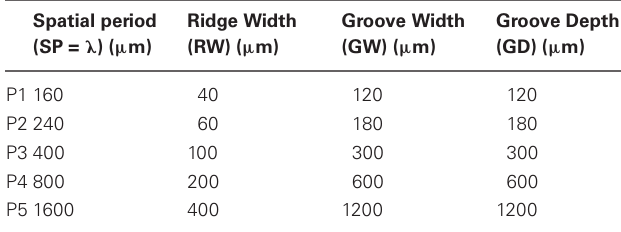
Table 2 | Set of periodic stimuli used for the experiment: geometrical dimensions of the grooved surfaces made of polyurethane resin.